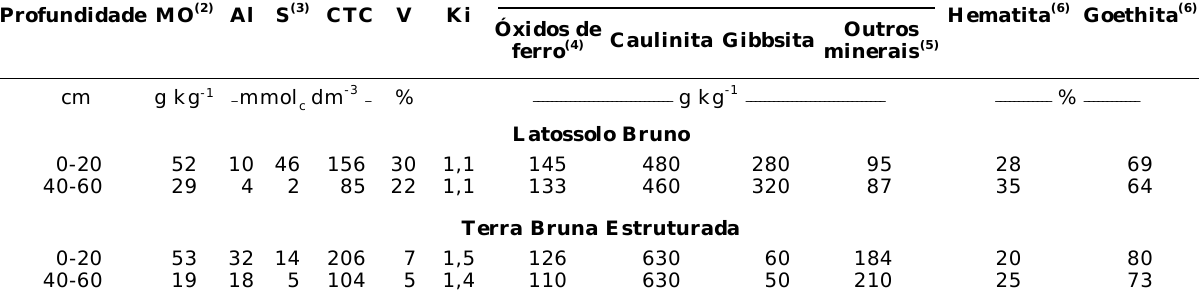
Quadro 2. Resultados médios (1) das análises químicas e mineralógicas de amostras de